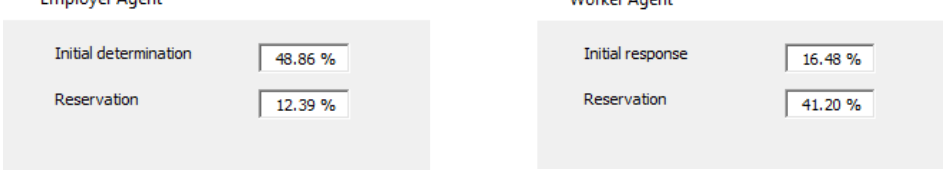
Figure 3. Employer Agent’s Initial Determination and Worker Agent’s Response to the Initial Determination in the First Round.